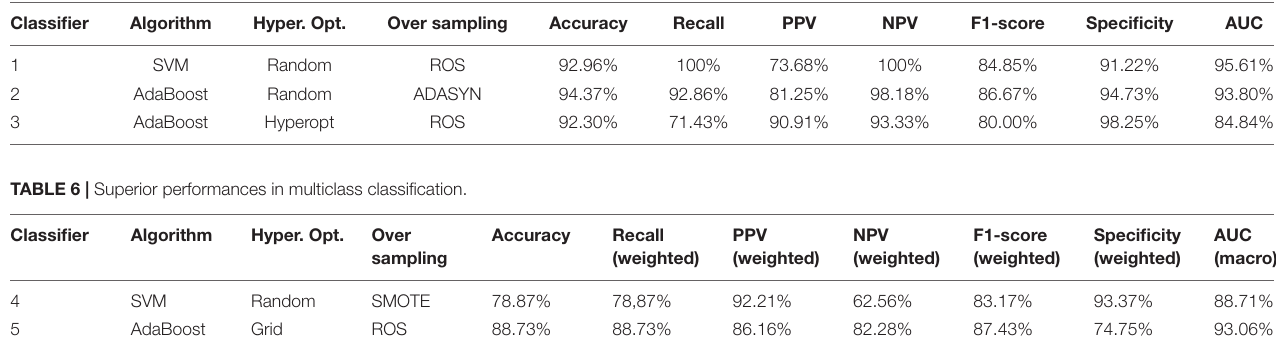
TABLE 5 | Superior performance in binary classification.